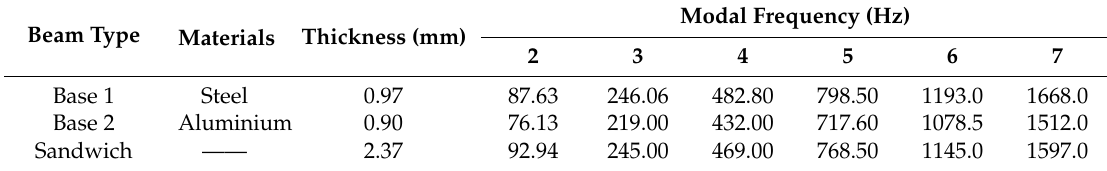
Table 2. Tested modal frequencies of the long asymmetrical sandwich beam specimen.